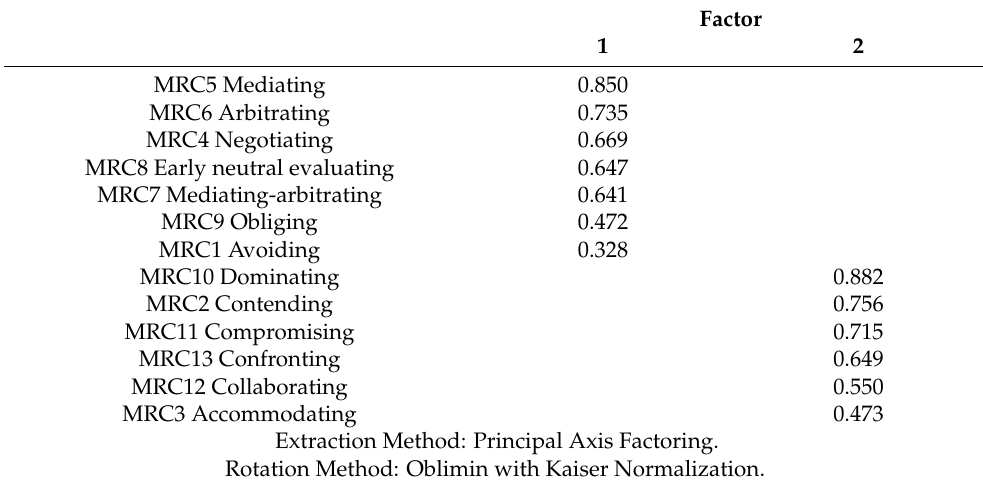
Table 5. Pattern matrix a.